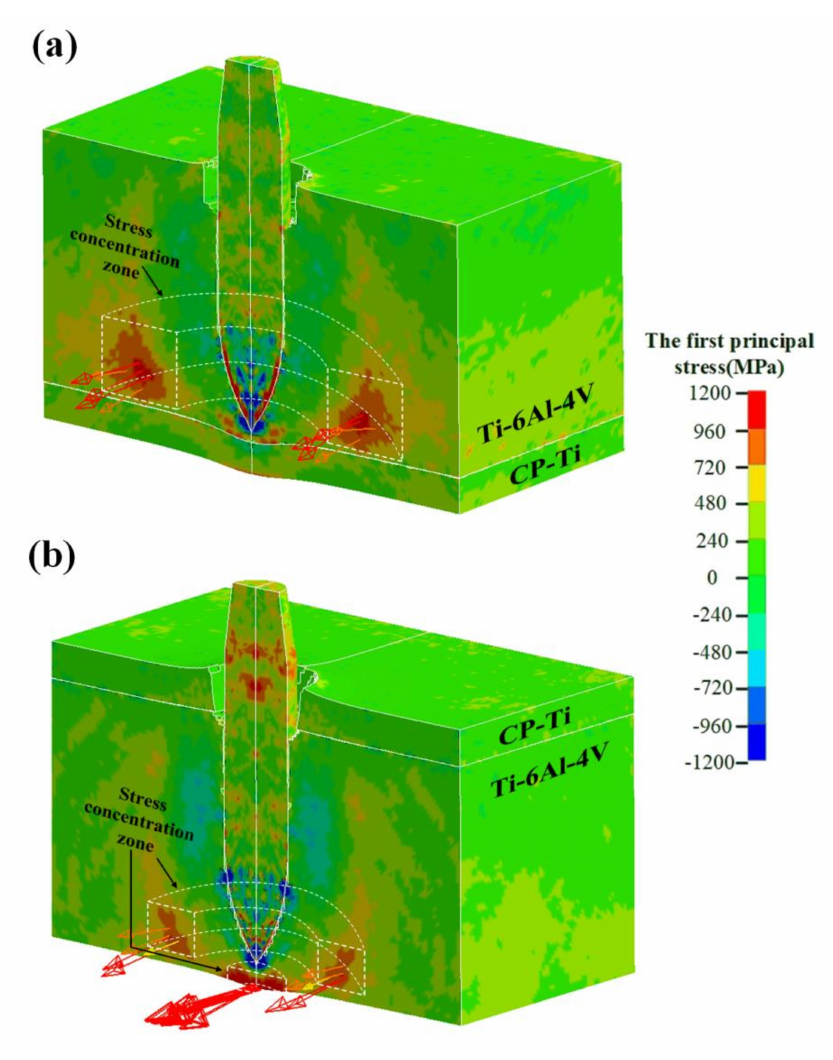
Figure 10. Contour of the first principal stress and the first principal stress vector of several typical elements comprising the cross-section: ( a ) Ti64 / CPTi and ( b ) CPTi /